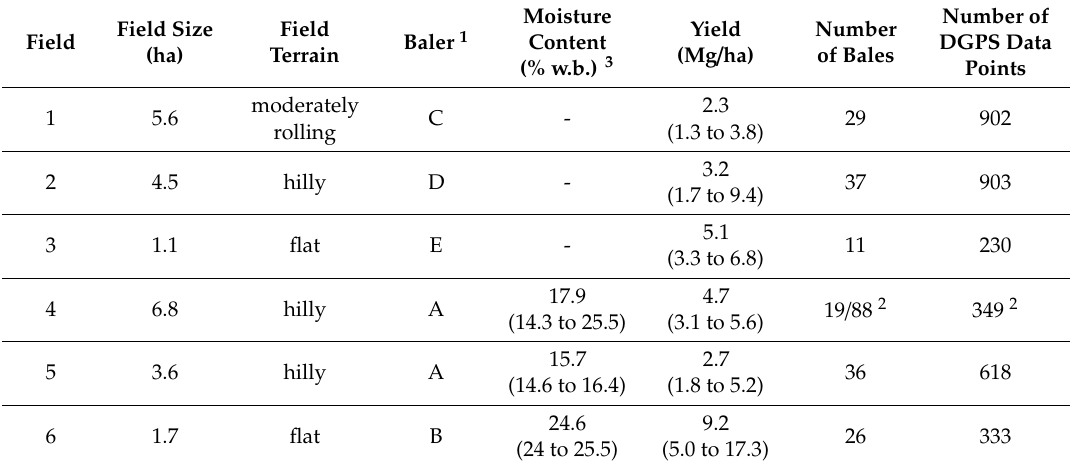
Table 1. Field characteristics, baler used, number of bales and number of Differential Global Positioning System (DGPS) points for the field.